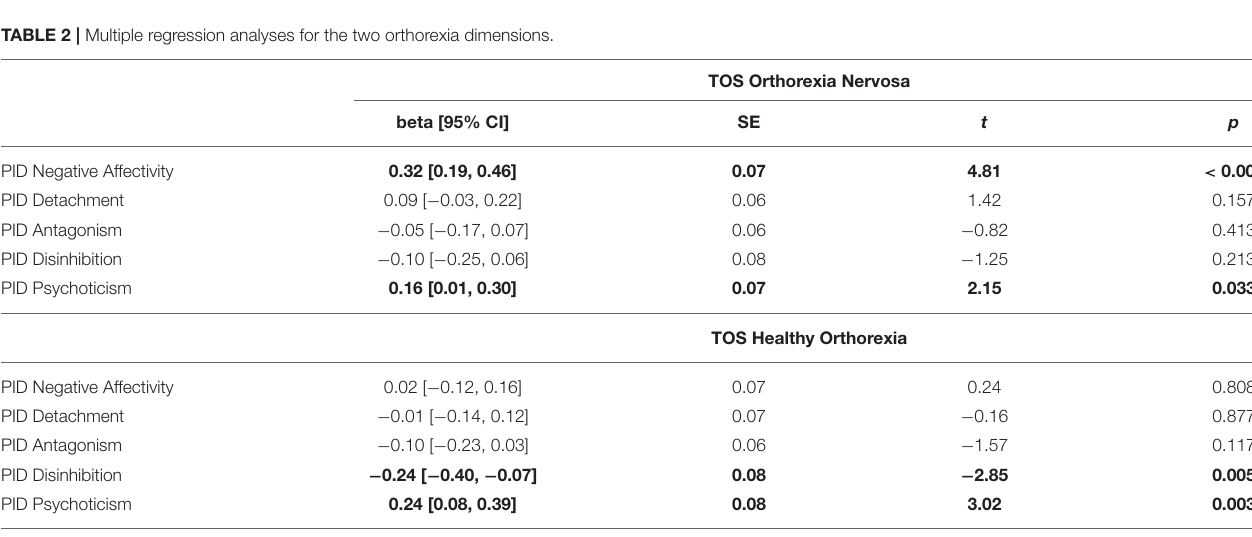
FIGURE 1 | Distribution of the TOS scores by dimension. Solid vertical line corresponds to the mean value. Dashed vertical lines, from left to right, correspond to first, second (median), and third quartile. Brown line correspond to the density plot.